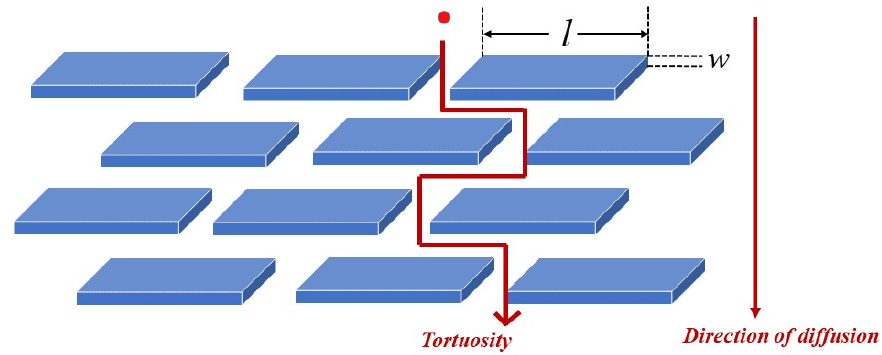
Figure 5. Schematic illustration of the tortuous path model.